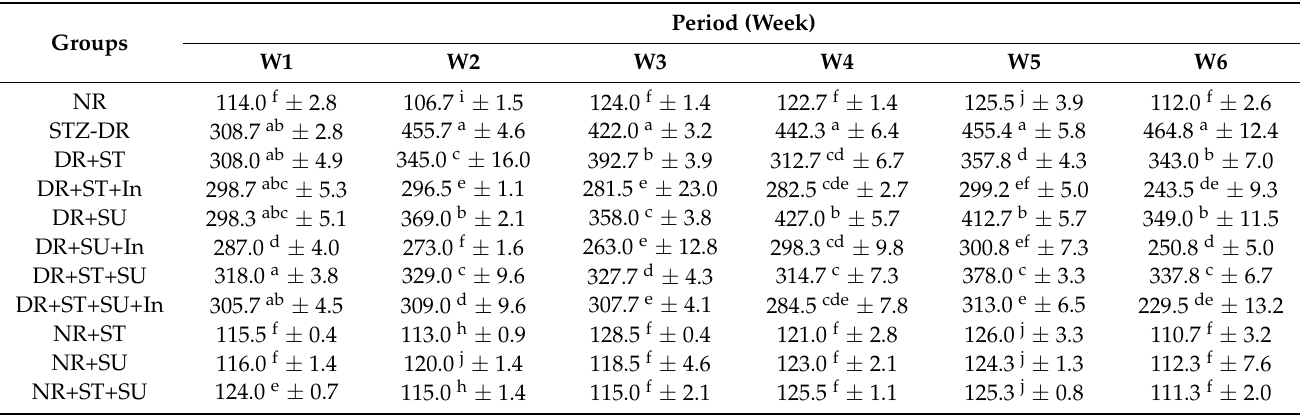
Table 1. Effects of stevioside and sucralose and their combination on the glucose level (mg dL − 1 ) in STZ-induced diabetes in rats, n =